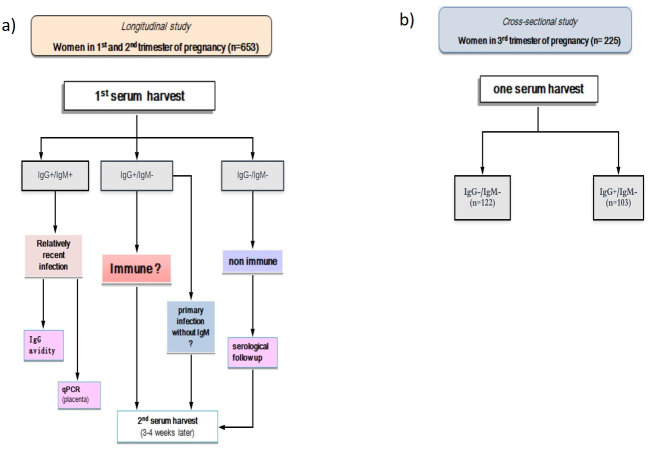
Flow chart of study sample and analyses for Toxoplasmosis survey: (a) flow chart focuses on the longitudinal study, including only women in the 1st and 2nd trimester of pregnancy; (b) flow chart focuses on the cross-sectorial study, including only women in the 3rd trimester of pregnancy.